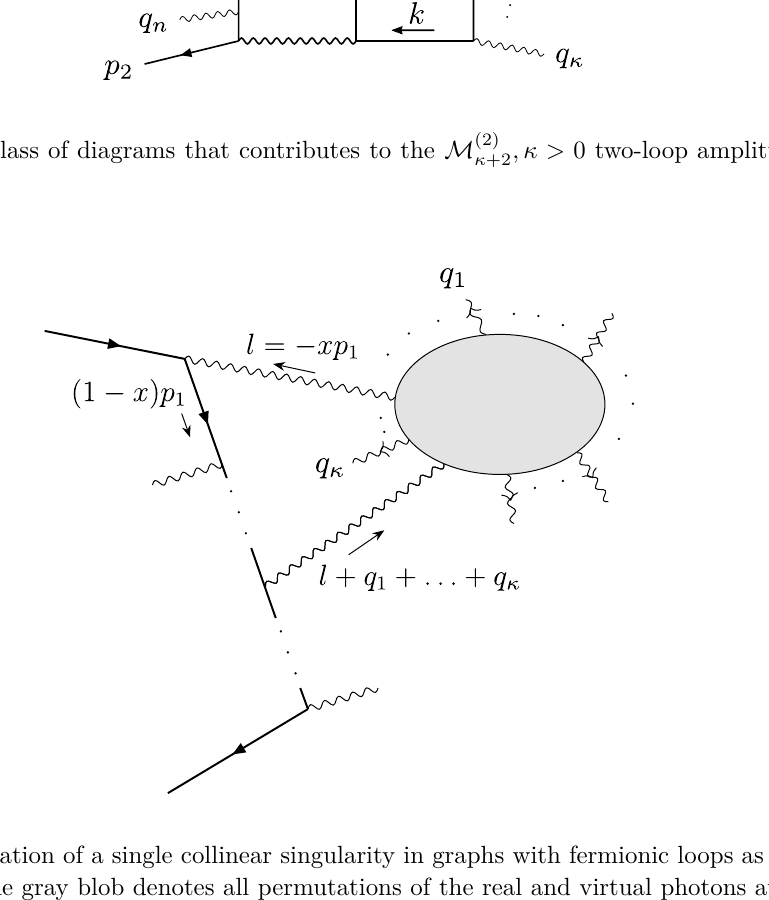
Figure 9. Illustration of a single collinear singularity in graphs with fermionic loops as l becomes parallel to p 1 . The gray blob denotes all permutations of the real and virtual photons attached to the fermion